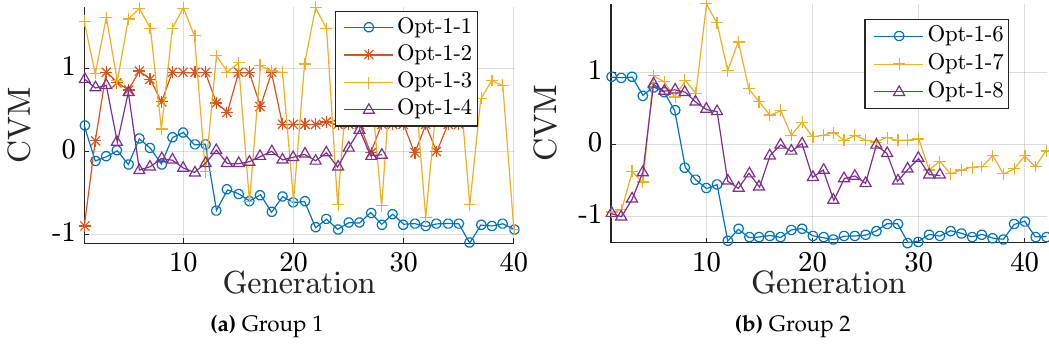
Figure 4. Development of the feasibility, given as the generation wise validity ratio and the generation median of Constraint Violation Measure (CVM). ( a ) Group 1; ( b ) Group 2.